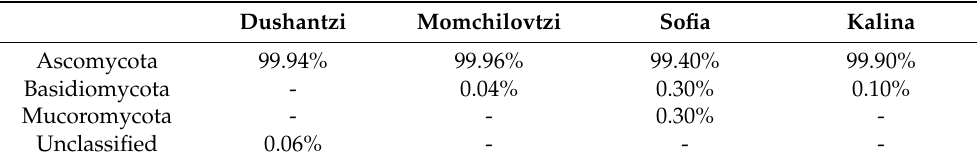
except for Dushantzi. Mucorcomycota was scarcely presented and only in Sofia with 0.30%. Of the fungal OTUs in Dushantzi, 0.06% were unclassified. Table 3. Fungal phyla found in the four locations.